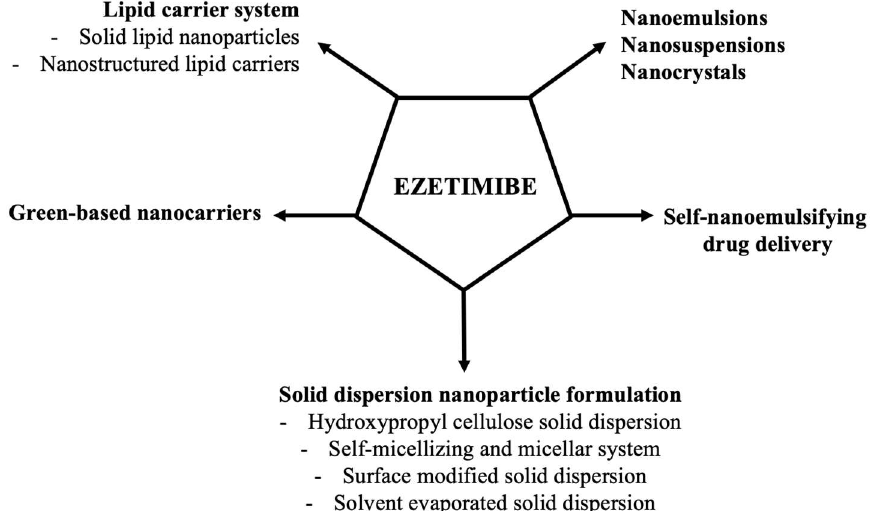
Figure 3. Proposed ezetimibe-loaded nanoparticle systems in targeted lipid-lowering therapy . Lipid Carrier Systems